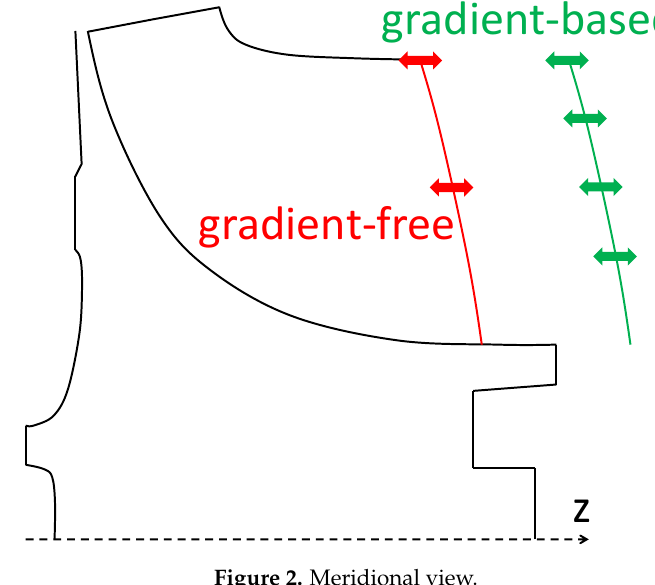
Figure 2. Meridional view.